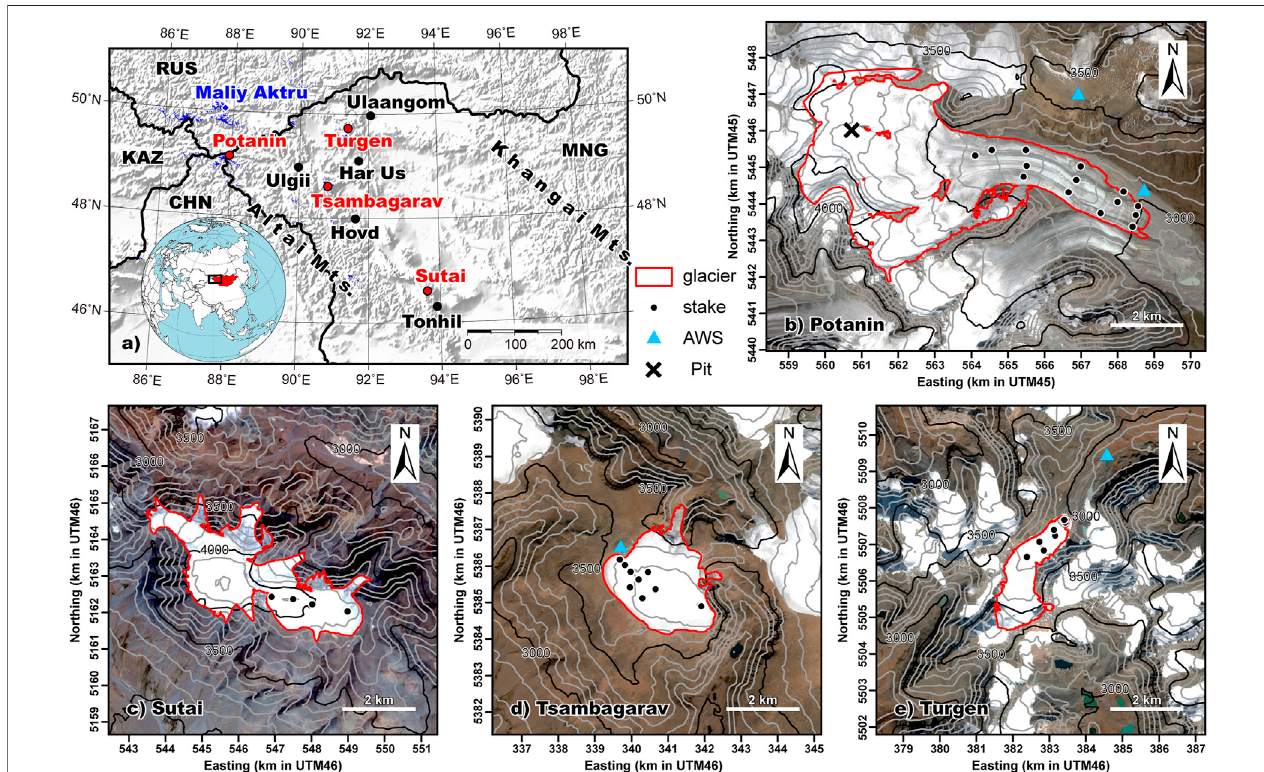
FIGURE1| Mapsof (A) ofthefourglacierlocations(redcircles)inwesternMongolia,and (B) Potanin, (C) Sutai, (D) Tsambagaravand (E) Turgenglaciers.Theinset map in (A) highlights Mongolia and the domain of panel (A) . MNG, RUS, CHN, and KAZ in panel (A) denote country names ofMongolia, Russia, China and Kazakhstan, respectively.Theblueshadingsin (A) denotetheglacieroutlinesfromtheGAMDAMGlacierInventory(Nuimuraetal.,2015;Sakai,2019).Blackcirclesandbluerhombus in (A) denote the meteorological stations, whose climate data were used in Supplementary Figure S1 , and Maliy Aktru Glacier, whose observed mass balance was compared with the estimation of this study ( Figure 8C and Supplementary Table S6 ), respectively. Red polygons denote the glacier outlines, which have been delineated from the Sentinel-2A images ( Table 1 ). Black dots and blue triangles denote the glacier mass-balance stakes and automatic weather stations (AWSs), respectively. Black cross on Potanin Glacier denotes a pit site at which accumulation was analyzed by pollen analysis (Nakazawa et al., 2015).